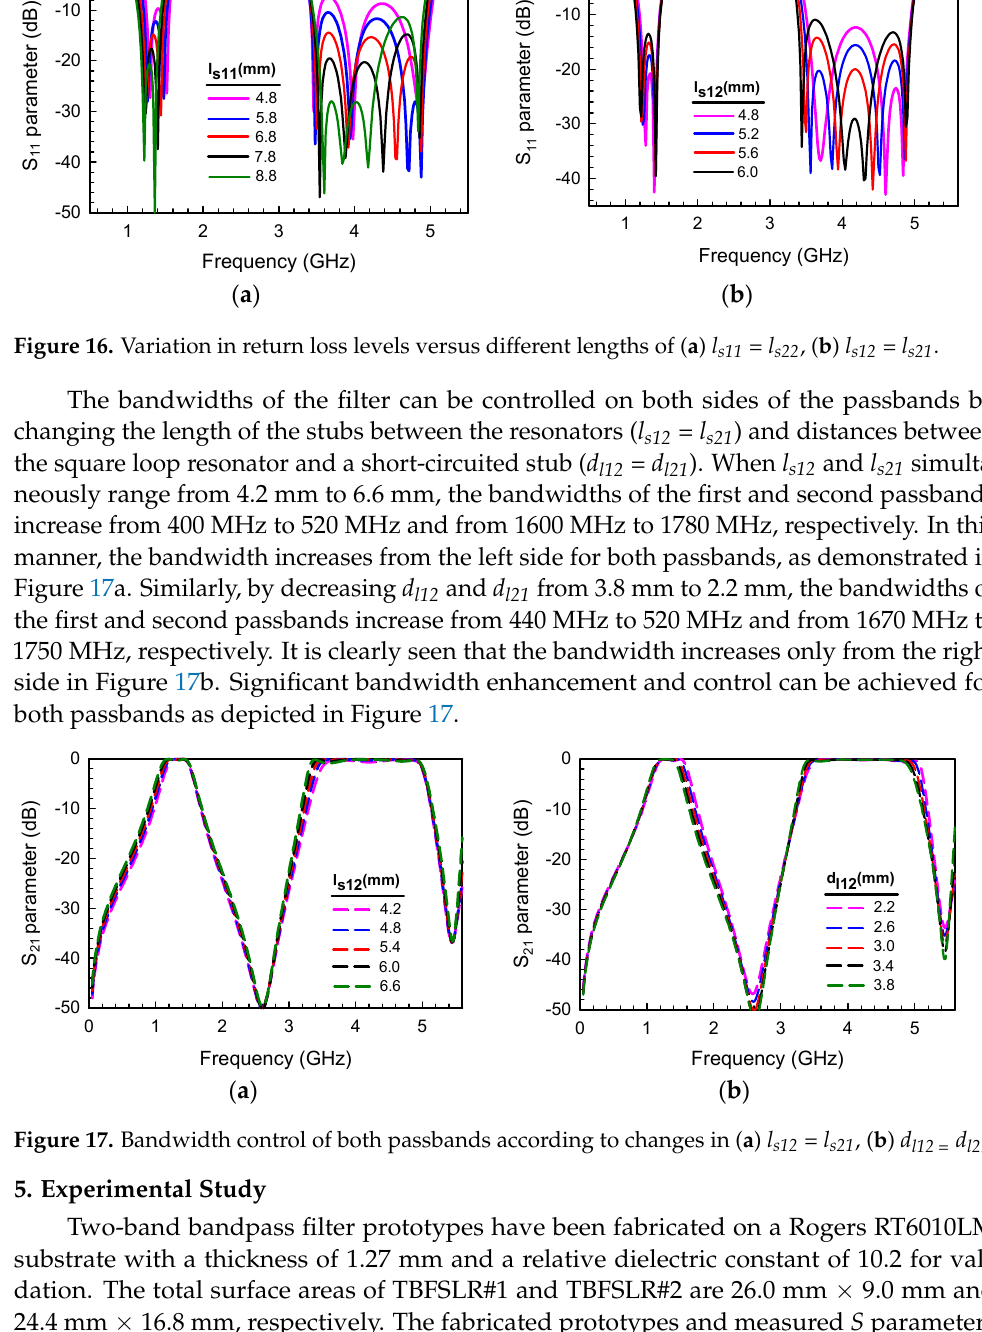
s12 = l s21 , ( b ) d l12 = d l21